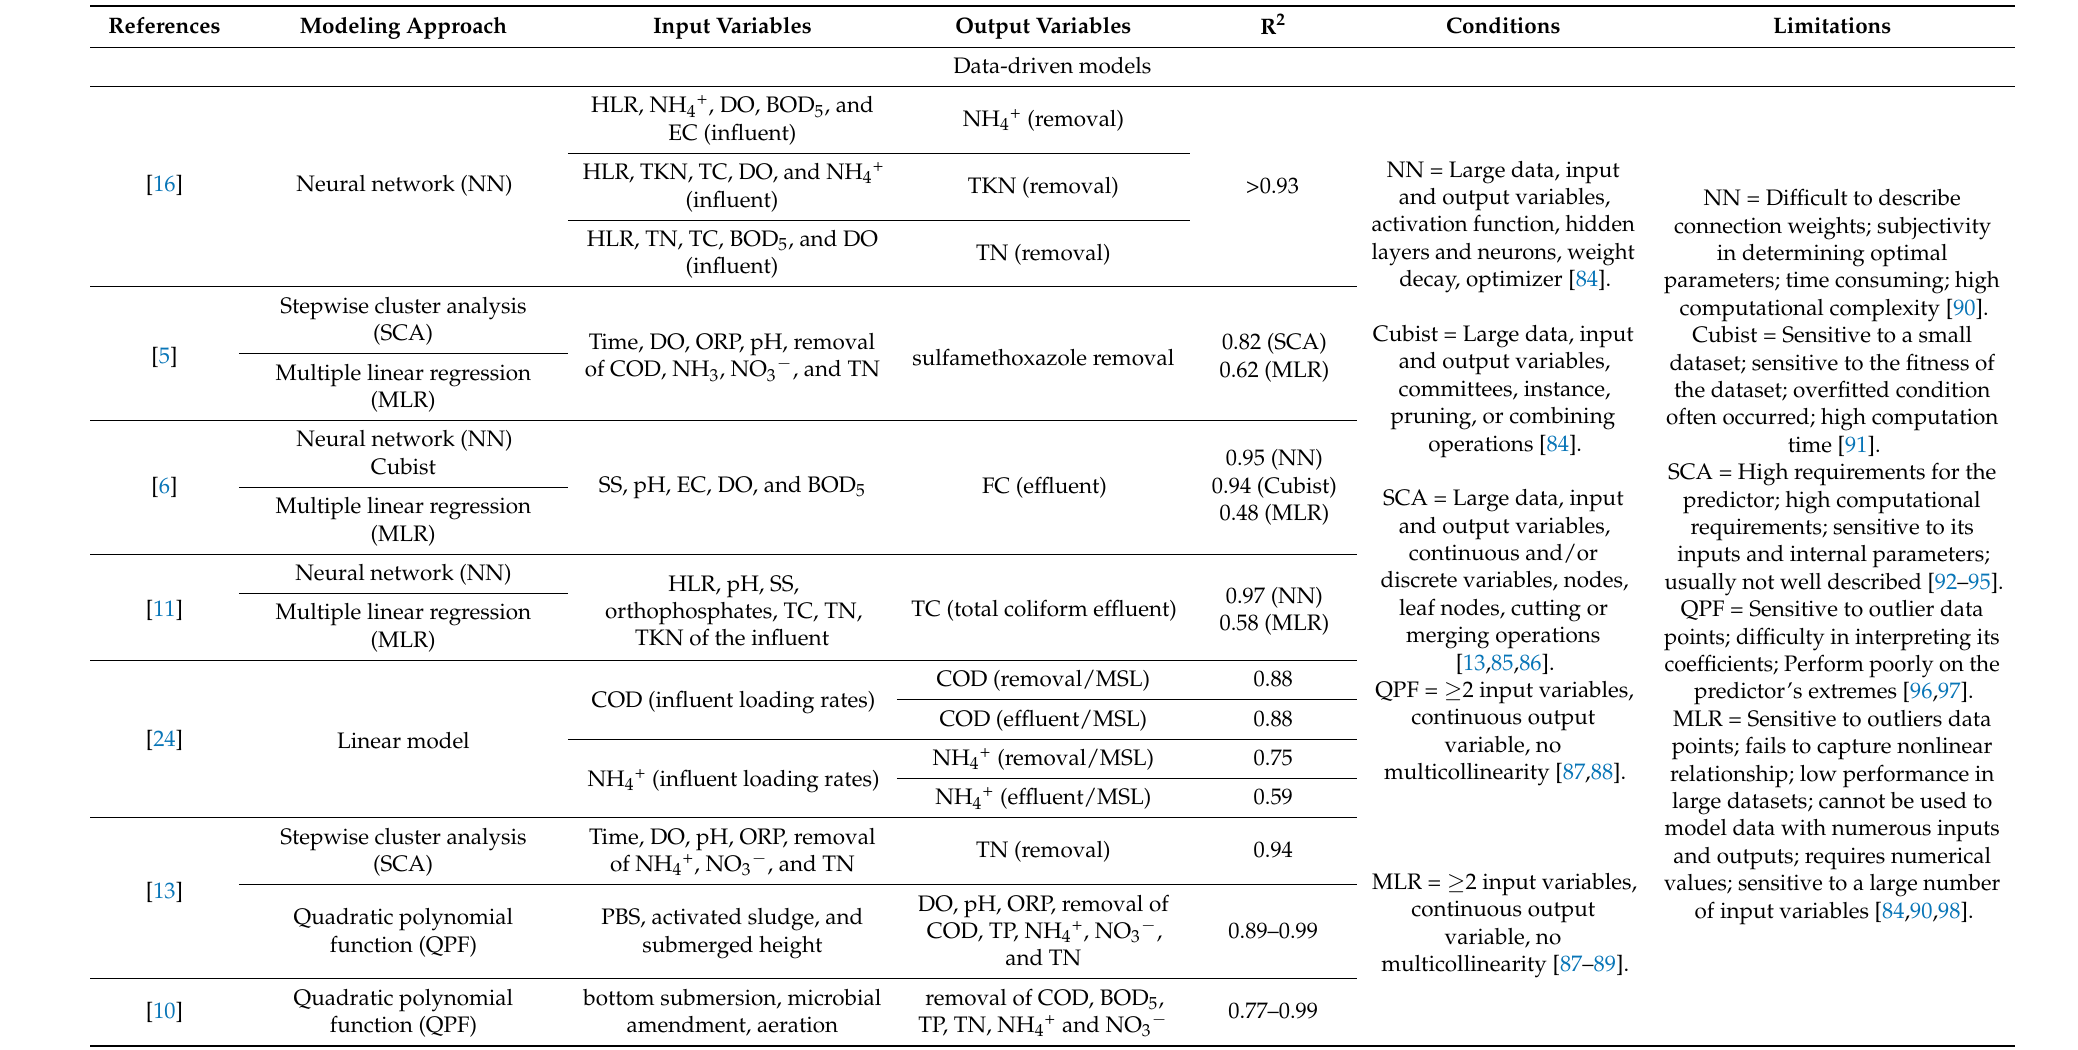
Table 3. Modeling approaches used for water quality indicators in the MSL